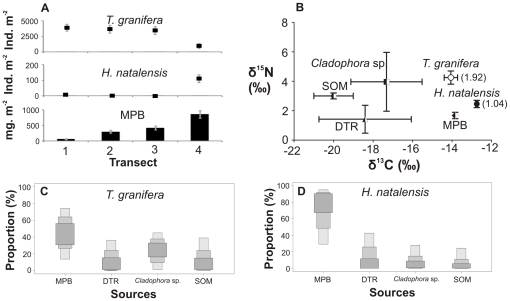
Gastropods, food sources and diets in Catalina Bay, 2007.(A) Four-point 6 m transect showing gastropod densities and microphytobenthic (MPB) biomass (as chl-a concentration). (B) Carbon and nitrogen stable isotope signatures of gastropods (number in brackets: trophic position) and their potential food sources; such as detritus (DTR) and sedimentary organic matter (SOM). SIAR boxplots show the proportional contribution (%) of different food sources to the diet of (C) Tarebia granifera and (D) Haminoea natalensis. Samples were collected in a freshwater seepage area of Catalina Bay in June 2007. Salinity ranged from 16 to 32. The water level of the South Lake rose due to the March 2007 mouth breach, after which the freshwater ponds associated with seepage areas along the eastern shores were flooded by seawater.